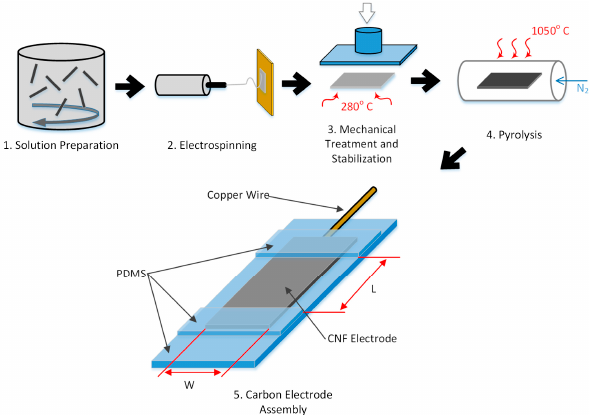
Figure 1. Synthesis process for mechanically treated polyacrylonitrile (PAN) Carbon Nanofiber (CNF)